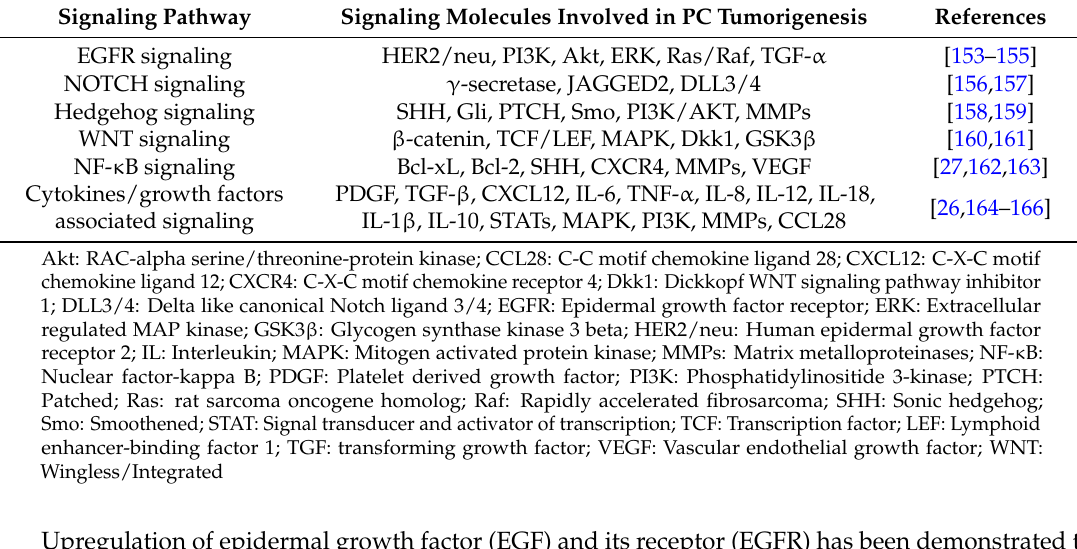
Table 2. Altered signaling pathways in pancreatic malignancy. Signaling Pathway Signaling Molecules Involved in PC